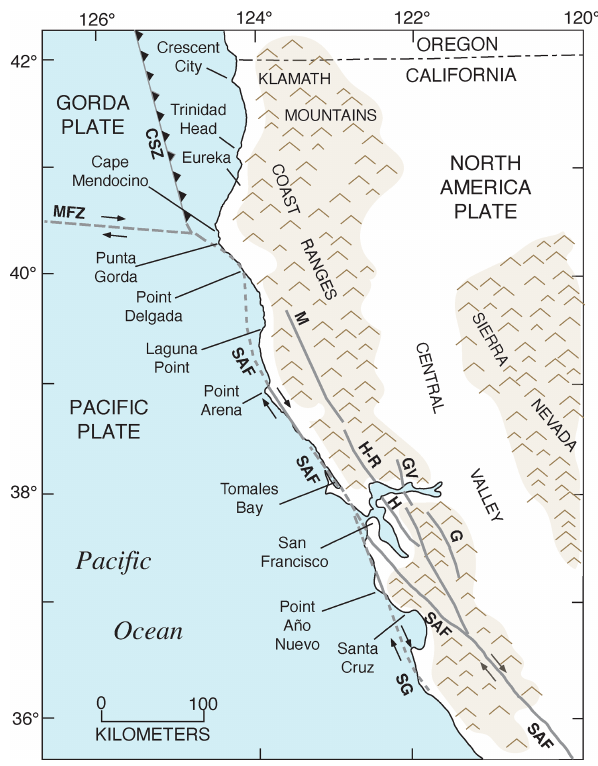
Figure 21. Map of coastal northwestern California showing geo- graphic and structural features and locations discussed in the text. CSZ: Cascadia Subduction Zone; MFZ: Mendocino Fault Zone; SAF: San Andreas Fault; SG: San Gregorio fault zone; H: Hay- ward Fault; M: Maacama Fault Zone; GV: Green Valley Fault; G: Greenville Fault; H-R: Healdsburg–Rodgers Creek Fault. Faults and tectonic features redrawn from Merritts (1996) and Wakabayashi